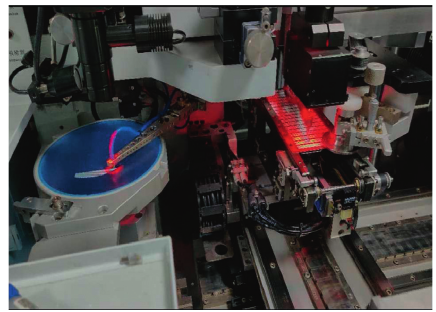
Figure 1: Die-bonding